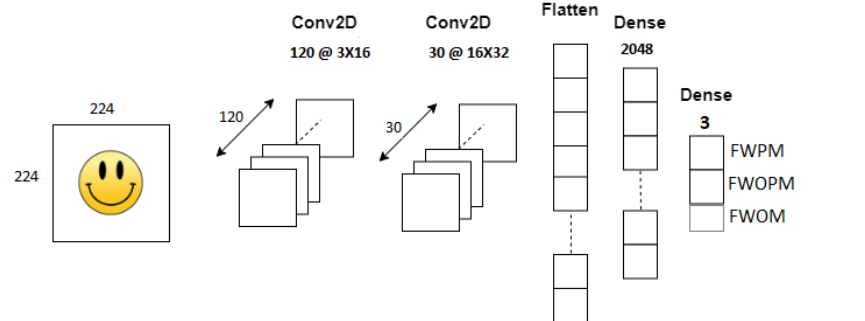
Figure 12. CNN work flow to detect faces with mask and without